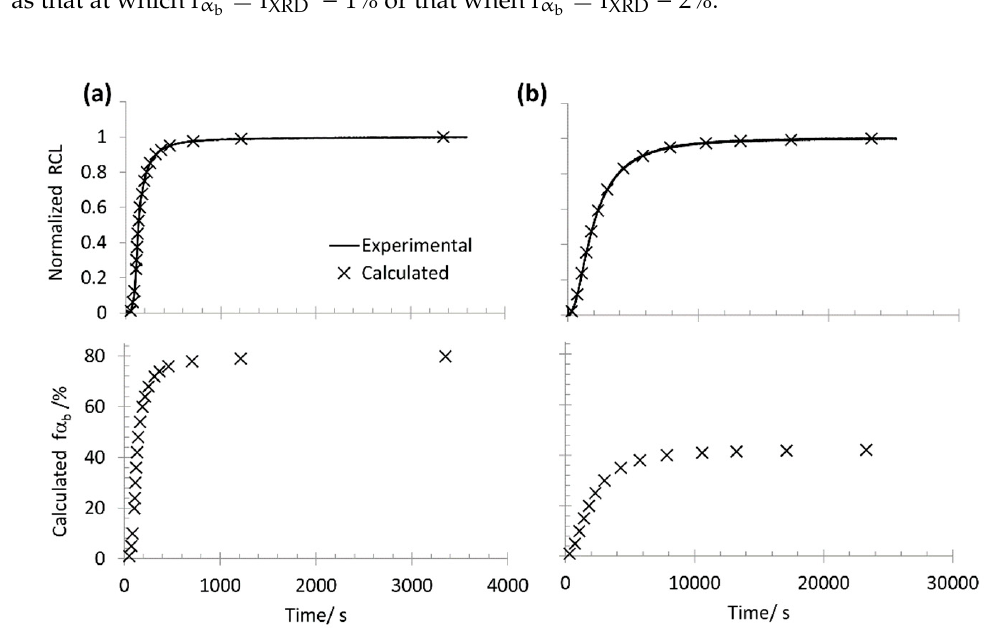
Figure 6. Illustrative example, for ( a ) Steel 1 and ( b ) Steel 2 treated at 350 °C, of the different outcomes of Method II, i.e., experimental normalized RCL compared to the calculated, and also the calculated fraction of bainitic ferrite ( f α b ) as a function of time.